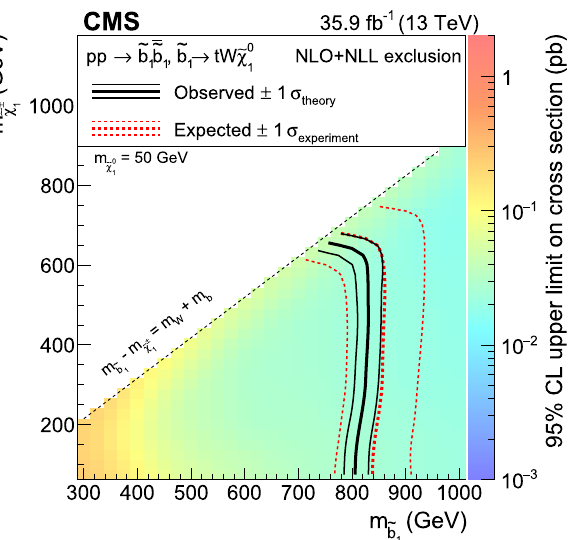
Fig. 7 Exclusion regions at 95% CL in the plane of m (cid:2) χ ± the T6ttWW model with m (cid:2) χ 0